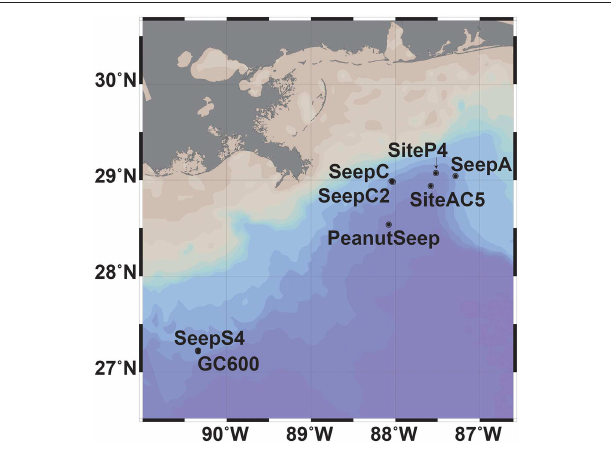
FIGURE 1 | Map showing the eight stations sampled in the Gulf of